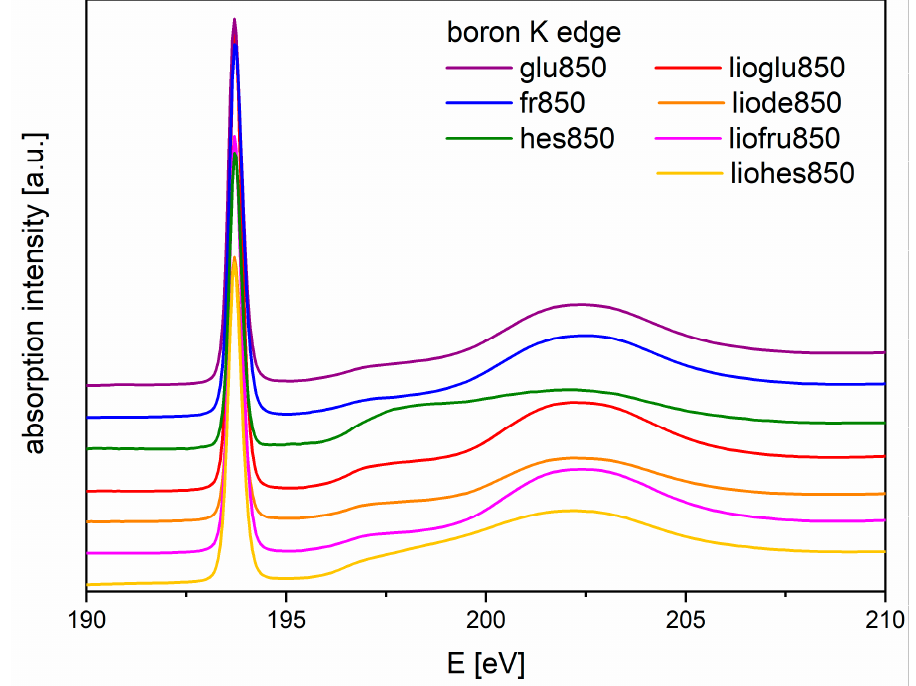
Figure 5. Boron edge spectra obtained from the PEEM/XAS research line for recrystallized and freeze-dried precursor after pyrolyzing at 850 °C.